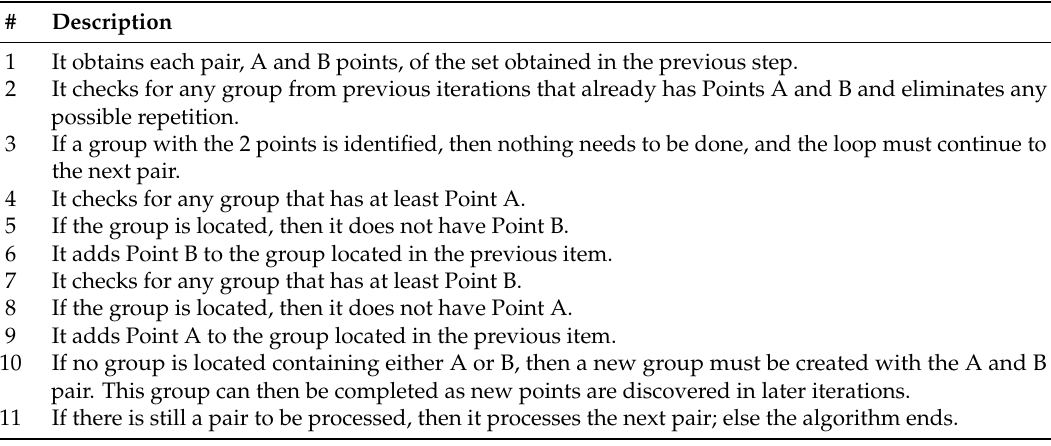
Figure 11. Algorithm 2: detection of groups. Source: the authors. Table 8. Detailed steps of Algorithm 1 (detection of